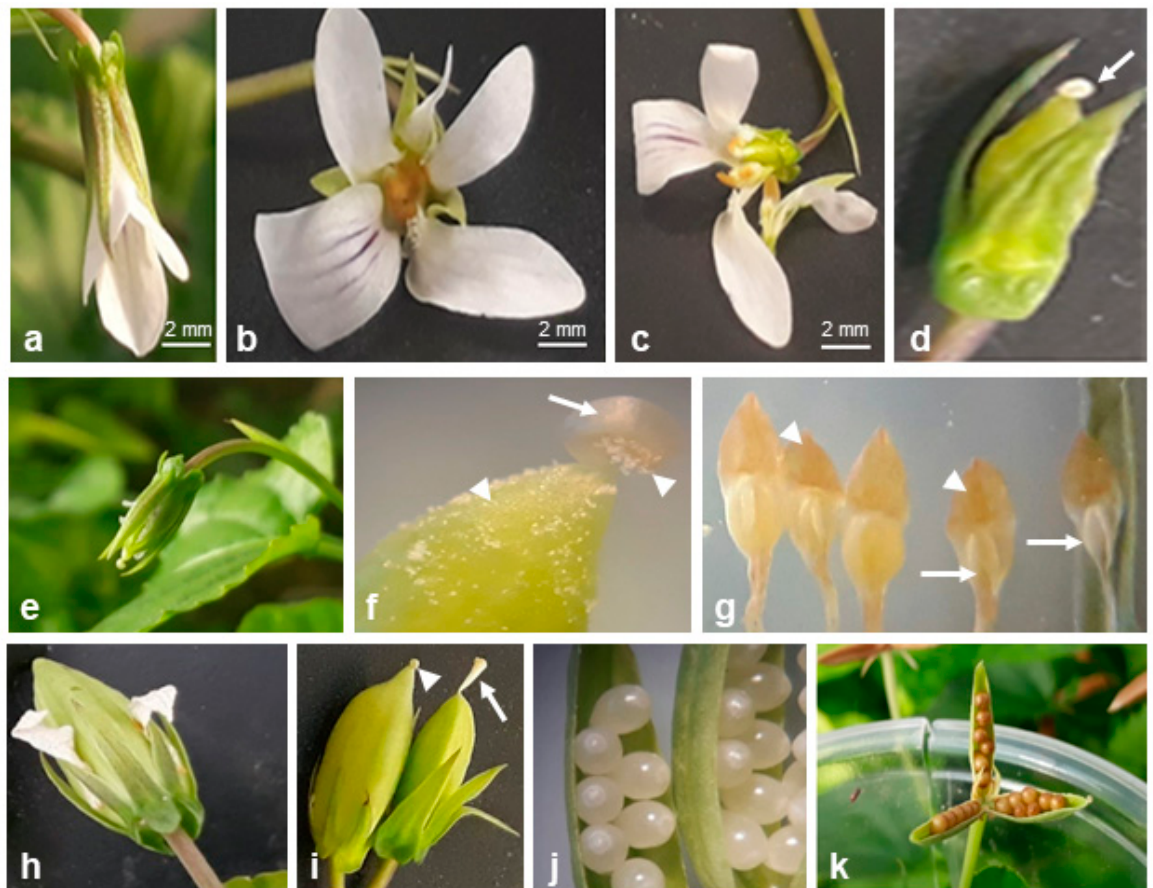
Figure 4. Viola caspia under greenhouse conditions. SEMCL and CL flowers and fruits. ( a – d ) SEMCL flowers at different stages of development ( a – c ), enlarged ovary, curved style of pistil (arrow) ( d ). ( e – g ) CL bud-like flower ( e ), enlarged ovary, curved style of pistil (arrow), pollen grains on stigma and ovary (arrowheads) ( f ), five stamens with reduced anthers (arrows) ending orange appendages (arrowheads) ( g ), enlarged ovaries ( h , i ); note differences in style of pistil shape, short and curved in CL (arrowhead in ( i )), straight in CH (arrow in ( i )). ( j ) Enlarged ovules in CL fruit, ( k ) seeds in CL fruit.